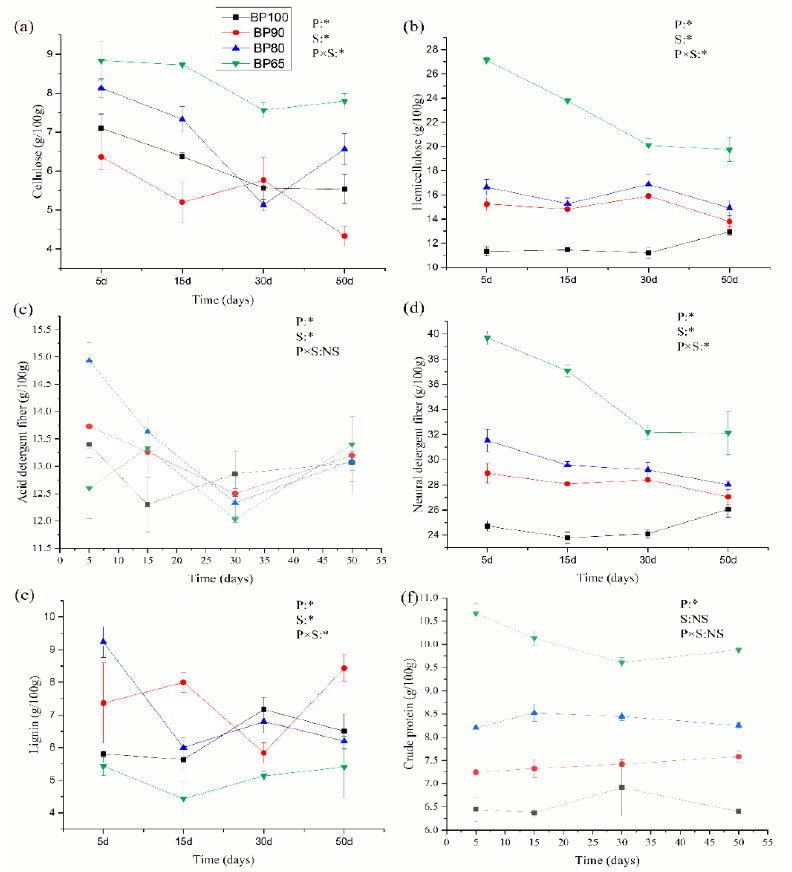
Figure 1. Dynamics of chemical composition including ( a ) cellulose, ( b ) hemicellulose, ( c ) acid detergent fiber, ( d ) neutral detergent fiber, ( e ) lignin, and ( f ) crude protein during silage fermentation. RMANOVA results were reported. P: mixing proportion; S: sampling time; NS, not significant ( p > 0.05); * p < 0.05.